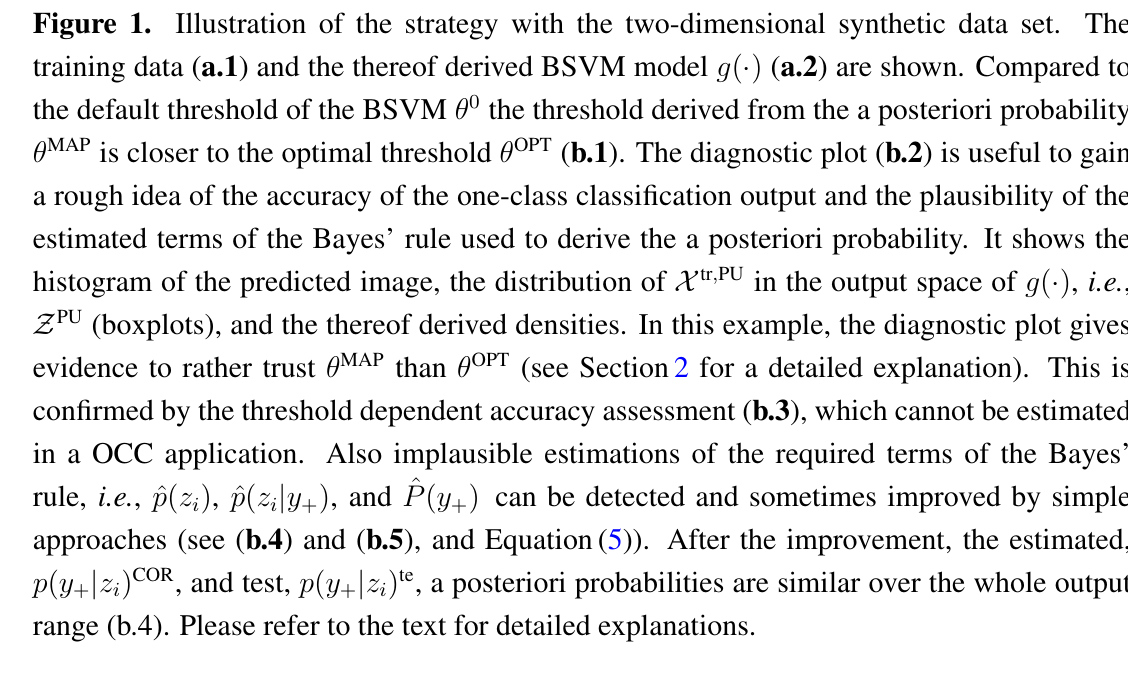
Figure 1. Illustration of the strategy with the two-dimensional synthetic data set. The training data ( a.1 ) and the thereof derived BSVM model g ( · ) ( a.2 ) are shown. Compared to the default threshold of the BSVM θ 0 the threshold derived from the a posteriori probability θ MAP is closer to the optimal threshold θ OPT ( b.1 ). The diagnostic plot ( b.2 ) is useful to